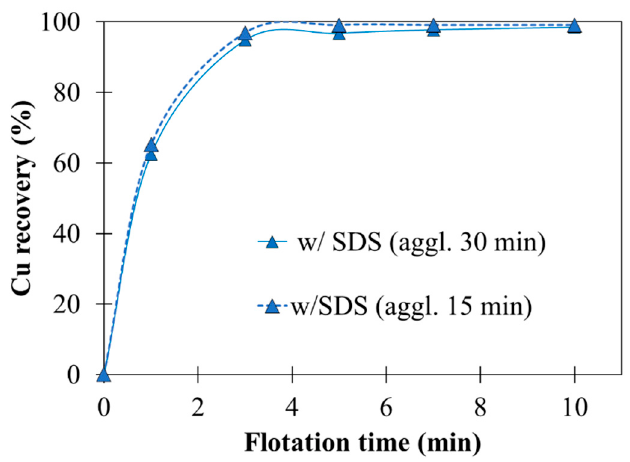
Figure 8. Cu recovery of agglomerate with SDS at agglomeration time of 15 and 30 min.